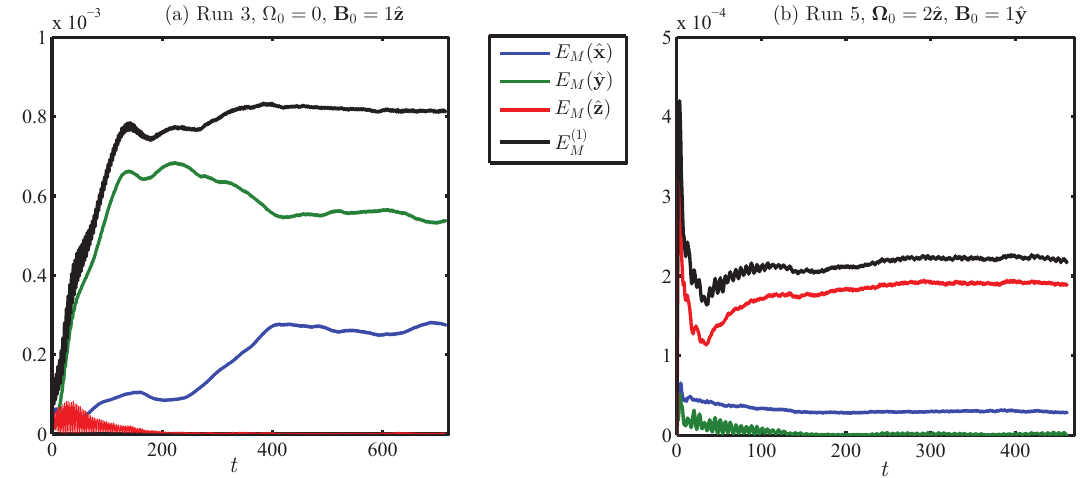
Figure 5: (colour online) Magnetic energies for the k = 1 modes versus time t for Runs (a) 3 and (b) 5. In these runs, B o so that H is not an invariant, although H M Ω o , and the only invariant is E . The ensemble prediction for both (a) and (b) is large and steady values during transition are anomalous.